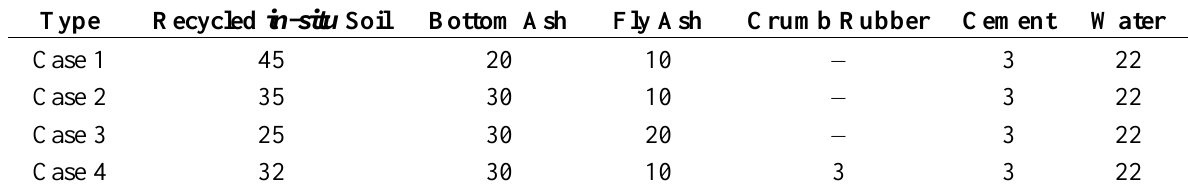
Table 3. Optimum mixing composition (wt%).